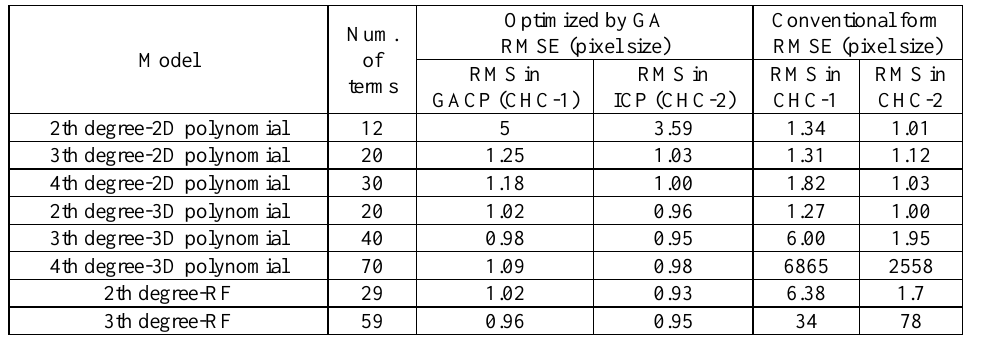
Table 1.1 Result of Optimization of 2D Polynomial, 3D Polynomial, RF model by GA for Worldview-2